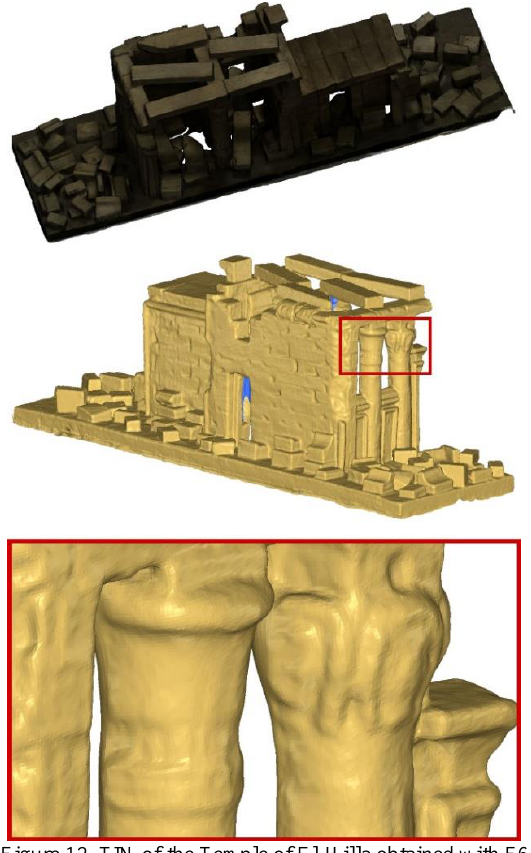
Figure 12. TIN of the Temple of El-Hilla obtained with F6 SR: with texture (top), without (centre) and zoom on the capitals (bottom)